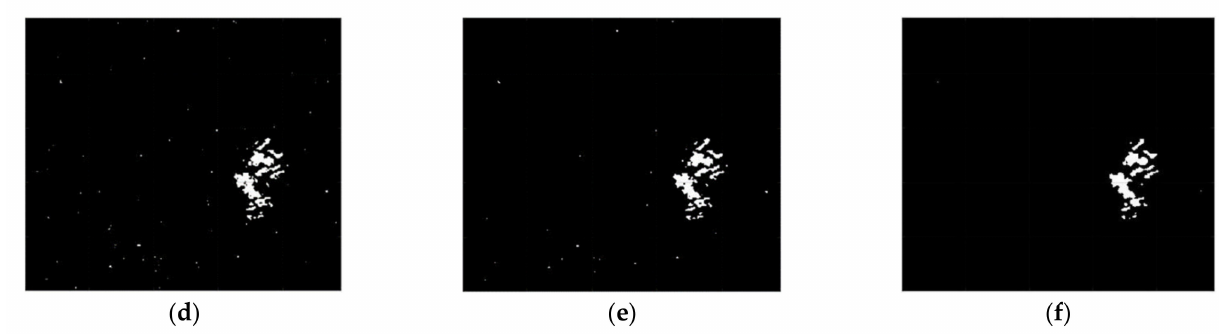
Figure 10. CDMs using dataset 1 obtained by six CD algorithms after median filtering in the post processing step. ( a ) CDM reconstructed by the CC. ( b ) CDM reconstructed by the LMT. ( c ) CDM reconstructed by the NRA. ( d ) CDM reconstructed by the SEST. ( e ) CDM reconstructed by the BGD. ( f ) CDM reconstructed by the proposed method.